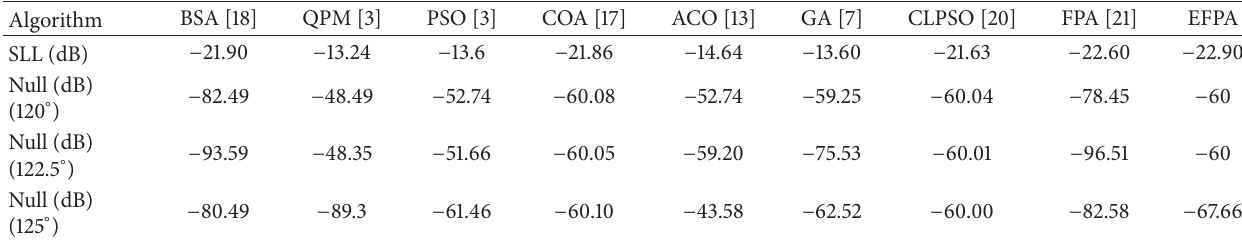
Table 11: Performance of different algorithms for 28-element LAA.